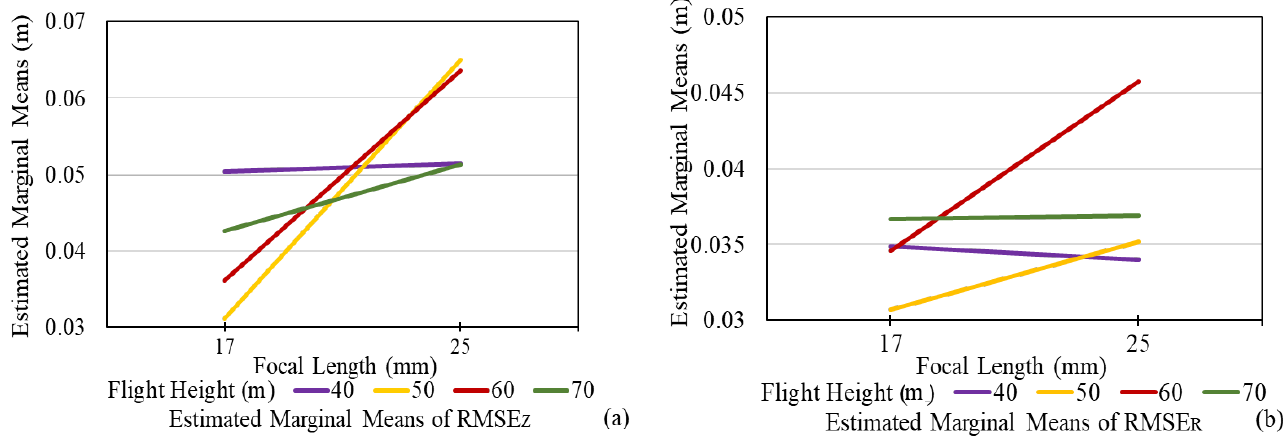
Figure 10. Interaction between Focal Length and Flight Height; ( a ) RMSE Z ; ( b ) RMSE R.